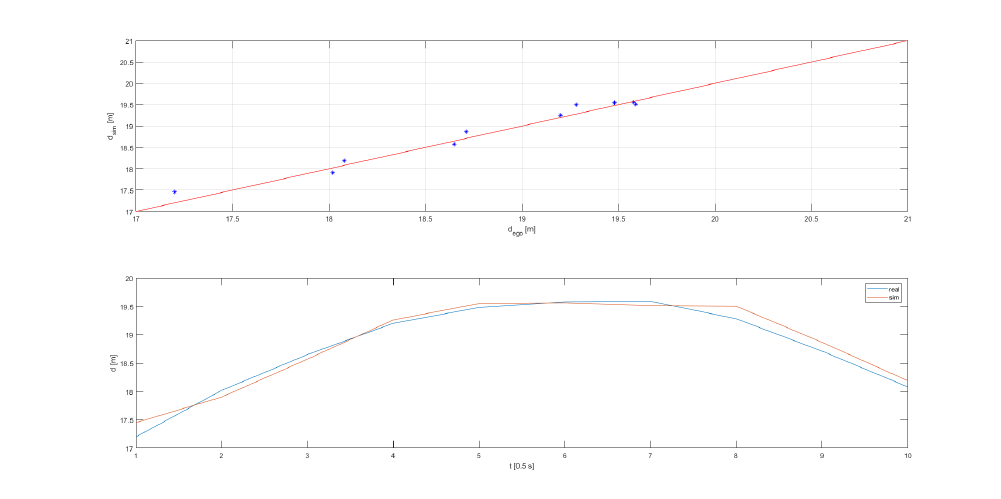
Figure A7. Validation of the real and estimated distance between ego target vehicle in scenario 2.